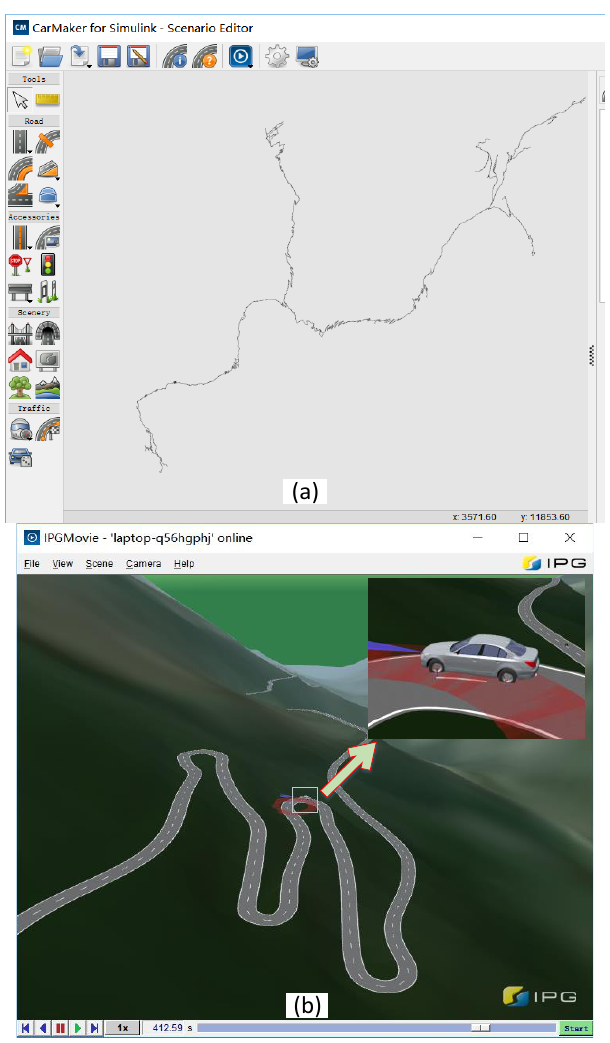
Figure 14. The mountain-road driving condition: ( a ) the global 2D aerial view; ( b ) the local 3D road scene diagram.